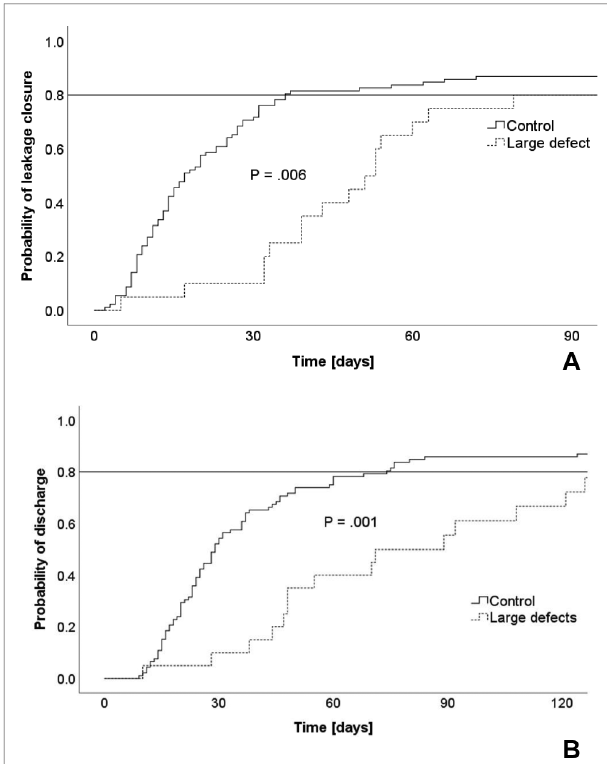
FIGURE 1 | Impact of large defects on recovery. ( A ) Duration of leakage therapy. ( B ) Length-of-hospitalization.